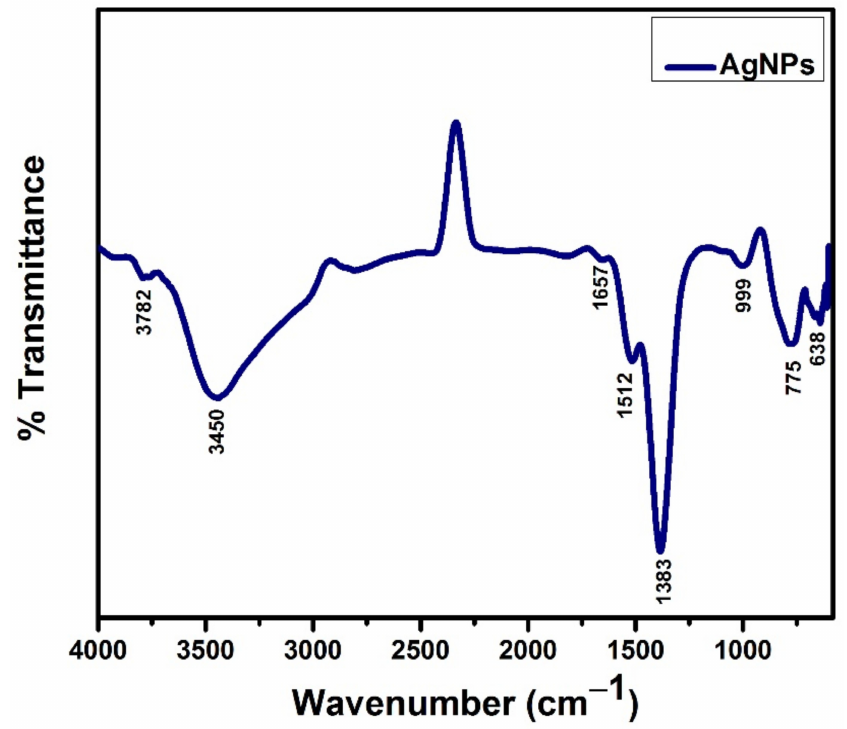
Figure 10. FTIR spectrum of optimized (run 4)